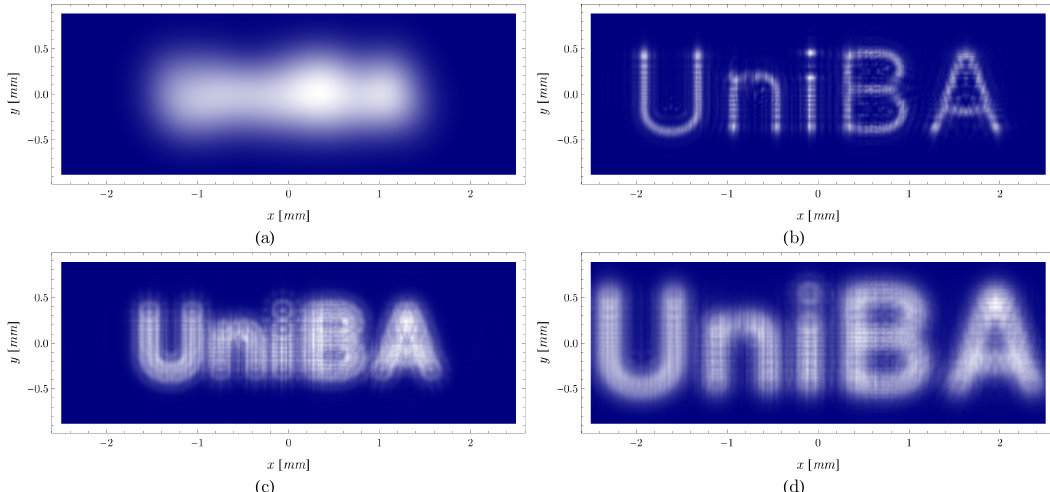
Figure 4. Comparison between the out-of focus ghost image of a transmissive mask ( a ) and three attempts ( b – d ) of refocusing it by applying Equation (12). The distance between the source and sensor D a is z a = 50mm, while the object is placed at z b = 75 mm, namely at 25 mm from the object plane. The source is characterized by a Gaussian intensity profile with standard deviation σ = 1 mm and wavelength λ = 500 nm. We show an image ( b ) refocused by using the correct value of z b , and two images ( c , d ) refocused at wrong distances z b = 60 mm and z b = 90 mm, respectively. Reproduced with the permission from [67], copyright 2017 Society of Photo-Optical Instrumentation